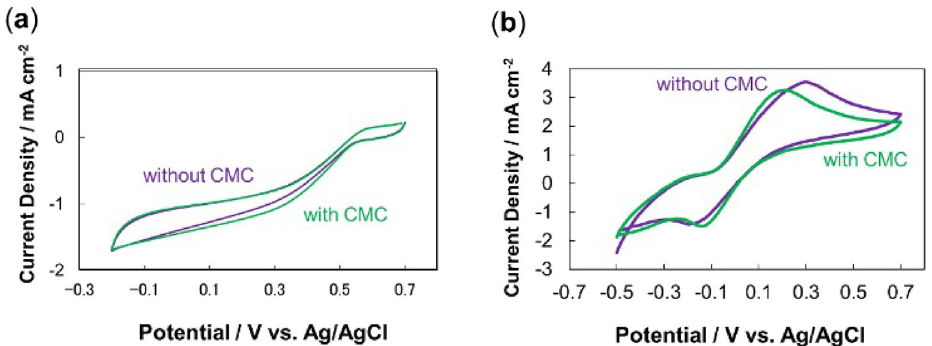
Figure 2. Cyclic voltammograms of ( a ) biocathodes, and ( b ) bioanodes, fabricated using MgOC inks with and without CMC. Scan rate: 10 mV s −1 ; 1 M phosphate buffer, pH 7.0; ( b ) 100 mM lactate. Biocathode enzyme: BOD; bioanode enzyme: LOx; bioanode mediator 1,2-NQ. Green: with CMC; violet: without